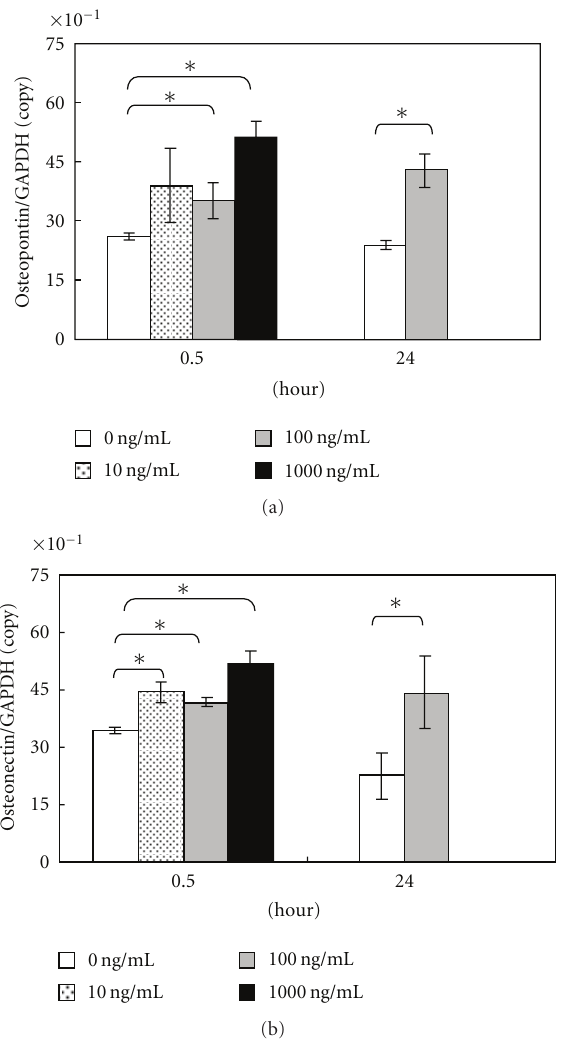
Figure 3: Graph of osteopontin (a) and osteonectin (b) copy number determined using LightCycler. Data represent means ± SD in five samples in three separate experiments. Significantly di ff erent from control values ( ∗ P < 0 . 05).